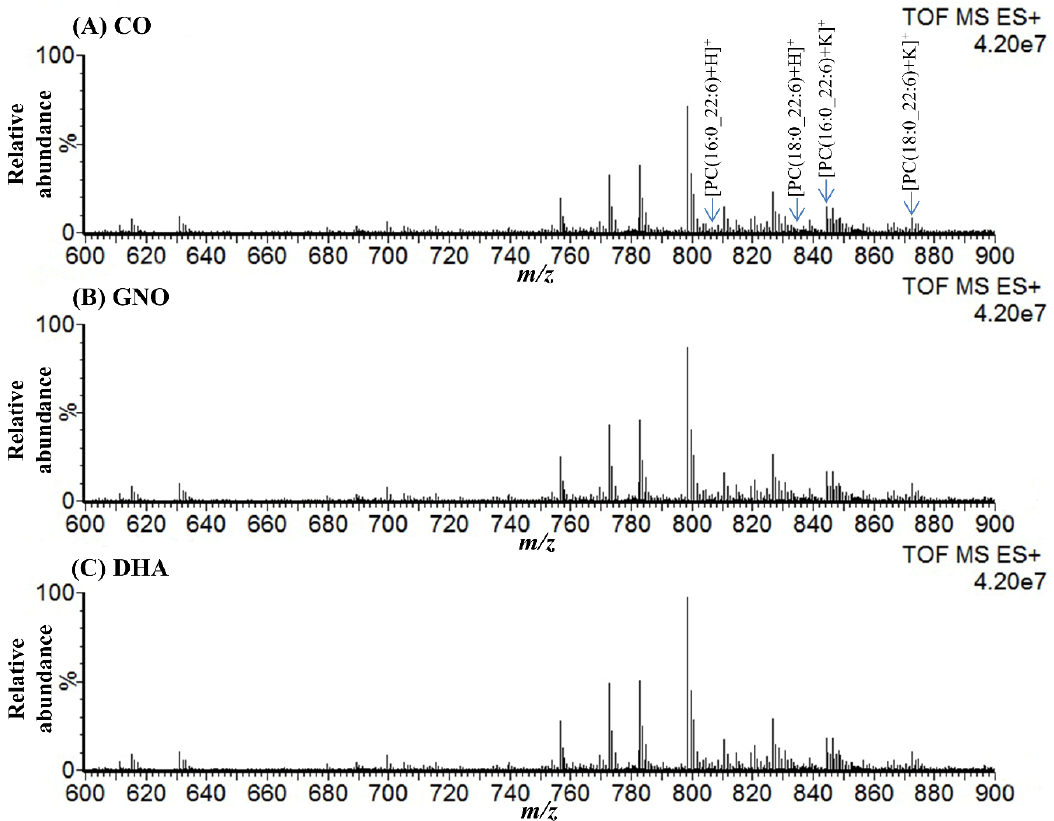
Figure 1. Representative DESI-MSI mass spectra acquired in positive ionization mode from the sagittal brain sections of SAMP8 mice. CO: corn oil treated SAMP8 mice; GNO: green nut oil treated SAMP8 mice; DHA: docosahexaenoic acid (C22:6) treated SAMP8 mice; PC: phosphatidylcholine, and m/z : mass to charge ratio.